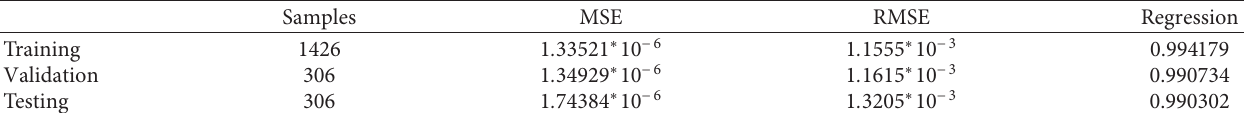
Table 7: Prediction errors in the training.